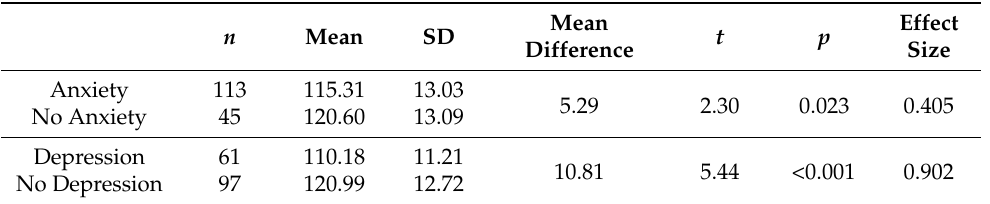
SD = 11.21) or negative (M = 120.99, SD = 12.72) for depression. Table 4. Differences in emotional intelligence between those exhibiting positive and negative screens for the presence of anxiety and